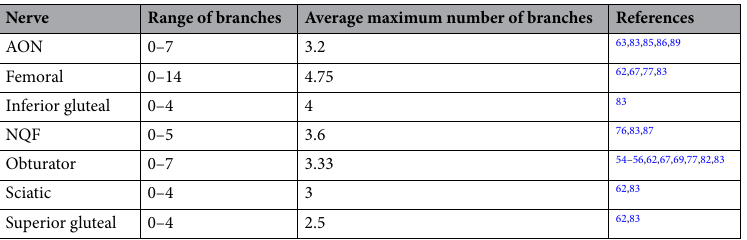
Table 5. Articular branches of the hip capsule. This table displays the range of branches and average maximum number of branches noted. Insufficient information prevented the average number of branches or information on the accessory femoral nerve from being displayed. AON accessory obturator nerve, NQF nerve to quadratus femoris.